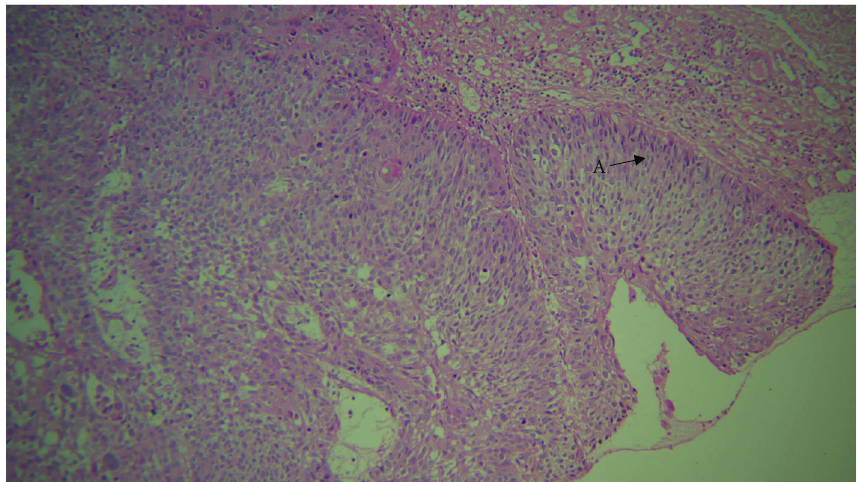
Figure 8: 10 × view. A: basaloid cells with peripheral